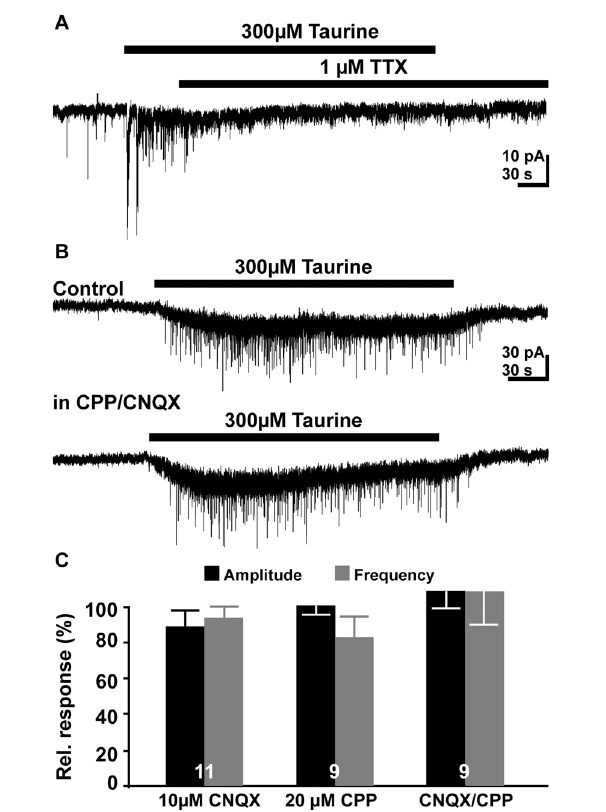
FIGURE 4 | Pharmacology of taurine responses . (A) Typical current registration illustrating that taurine-induced increase in the PSC frequency was suppressed in the presence of 1 µ M TTX. (B) Typical current registration illustrating that the taurine-induced increase in PSCs frequency was not affected in the presence of 10 µ M CNQX 6-cyano-7- nitroquinoxaline-2,3-dione (CNQX) + 20 µ M ( ± ) R(-)-3-(2-carboxypiperazine-4-yl)-propyl-1-phosphonic acid (CPP). (C) Statistical analysis of the effect of glutamatergic antagonists on relative frequency and amplitude of taurine-induced PSCs. Bars represent mean ± SEM, numbers of experiments are given in the bars. Inhibition of ionotropic glutamate receptors by bath appli- cation of 10 µ M CNQX or 20 µ M CPP had no